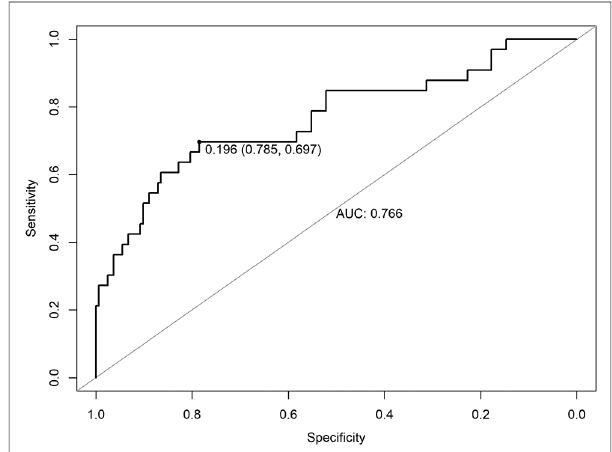
FIGURE 2 ROC of risk factors for PCCs for patients undergoing major noncardiac surgery in high-attitude areas. ROC, receiver operating characteristic; AUC, area under the curve.